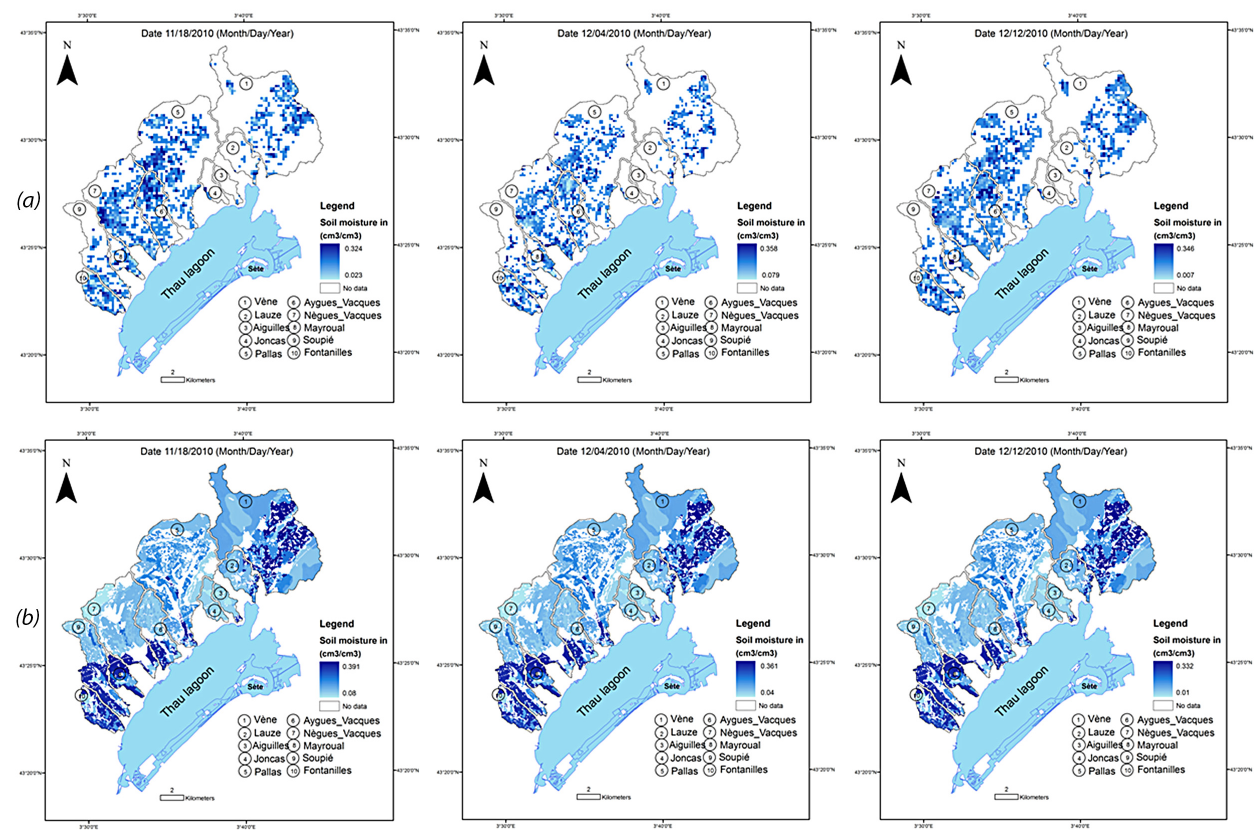
Figure 11. Distribution of the soil moisture within the Thau catchment for three different dates; (a) is the observed soil moisture (Baghdadi et al., 2012) and (b) is the predicted soil moisture based on the regionalization results. Table 7. Statistical criteria of the 95% confidence observed and predicted soil moisture values on the three dates at the Thau